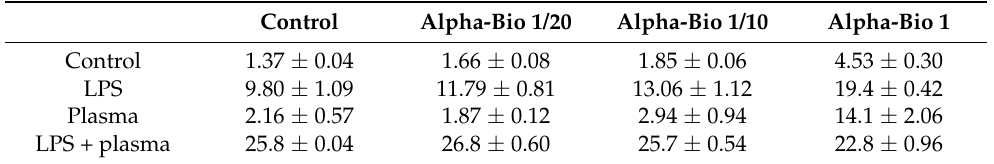
Table 2. Analysis of the expression levels of the CD54 molecule on the surface of THR-1 cells after 24 h of incubation with NSMP from the Alpha-Bio system.